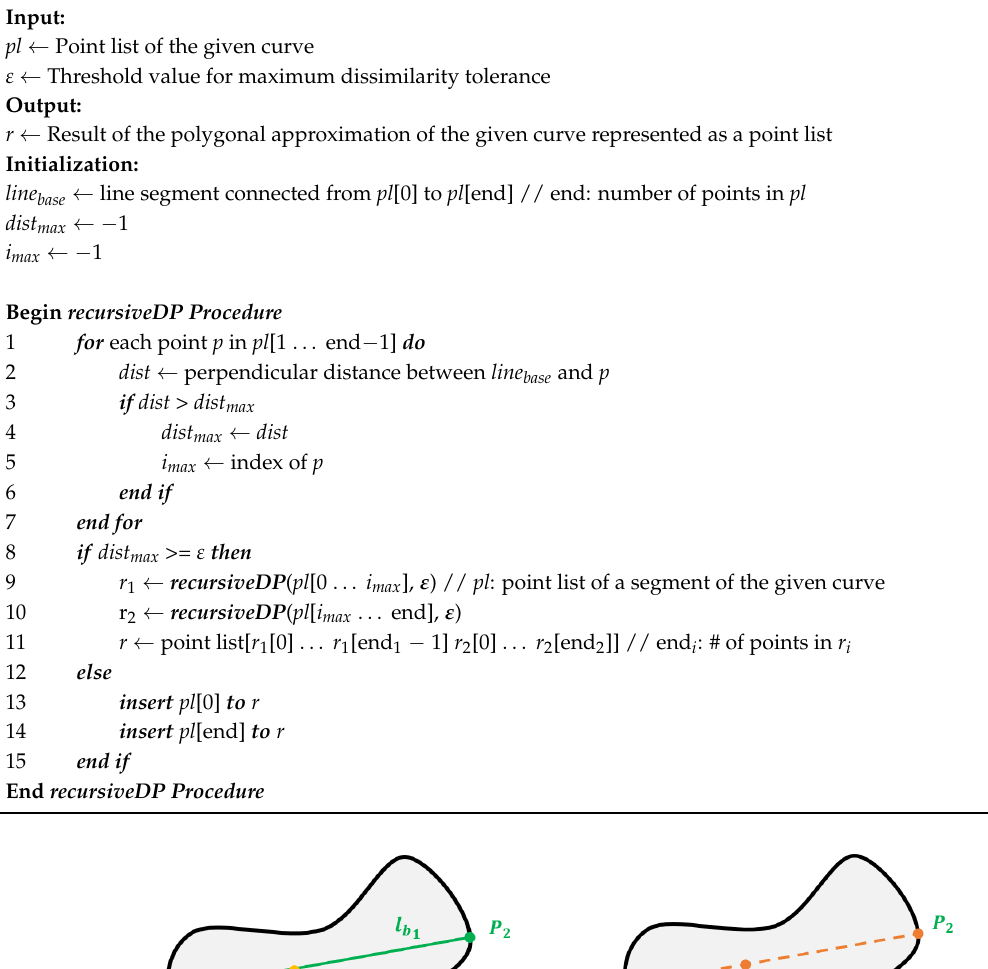
Algorithm 2. Pseudo Code of the Recursive DP.